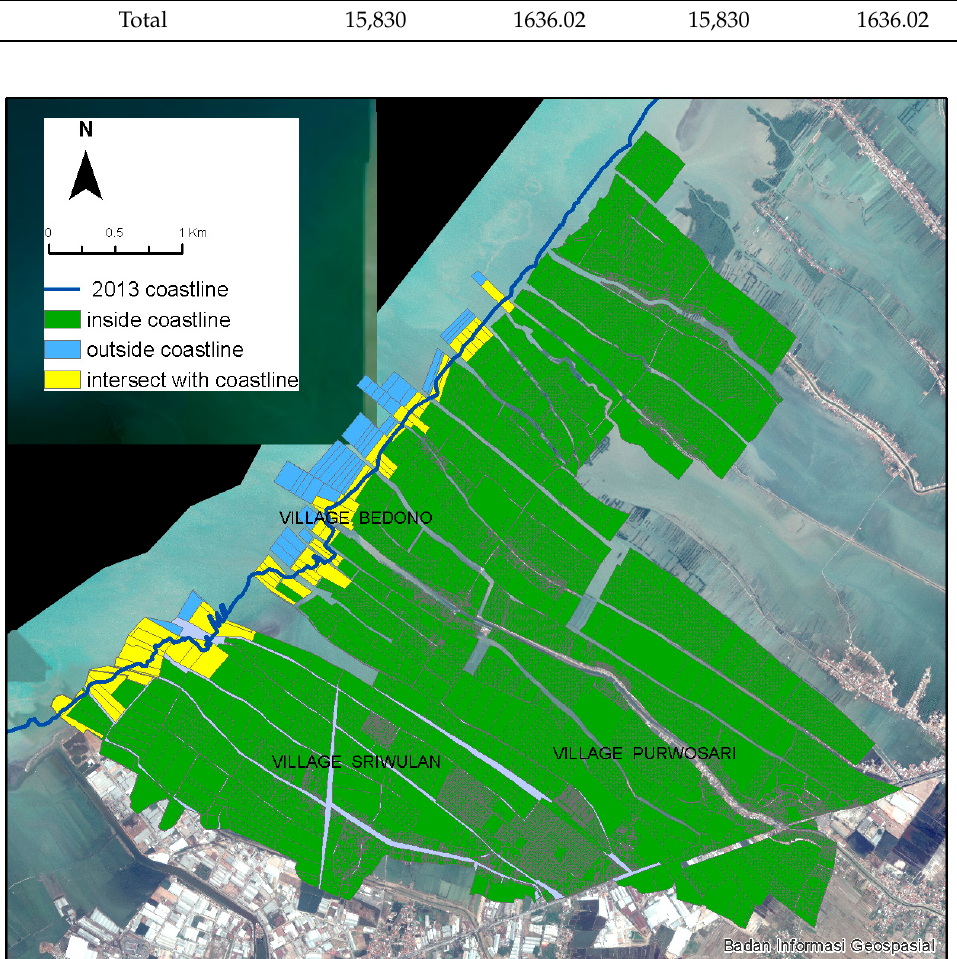
Figure 2. Land parcel from taxation map overlaid with 2013 coastline. The 2013 coastline was accessed from the Ministry of Marine and Fisheries, while the taxation map was accessed from Local Land Office in Kabupaten Demak. The blue figure shows land parcel located outside the coastal area, while the yellow parcel depicts land parcel that intersect with the coastline, and the green parcels located inside the coastline.